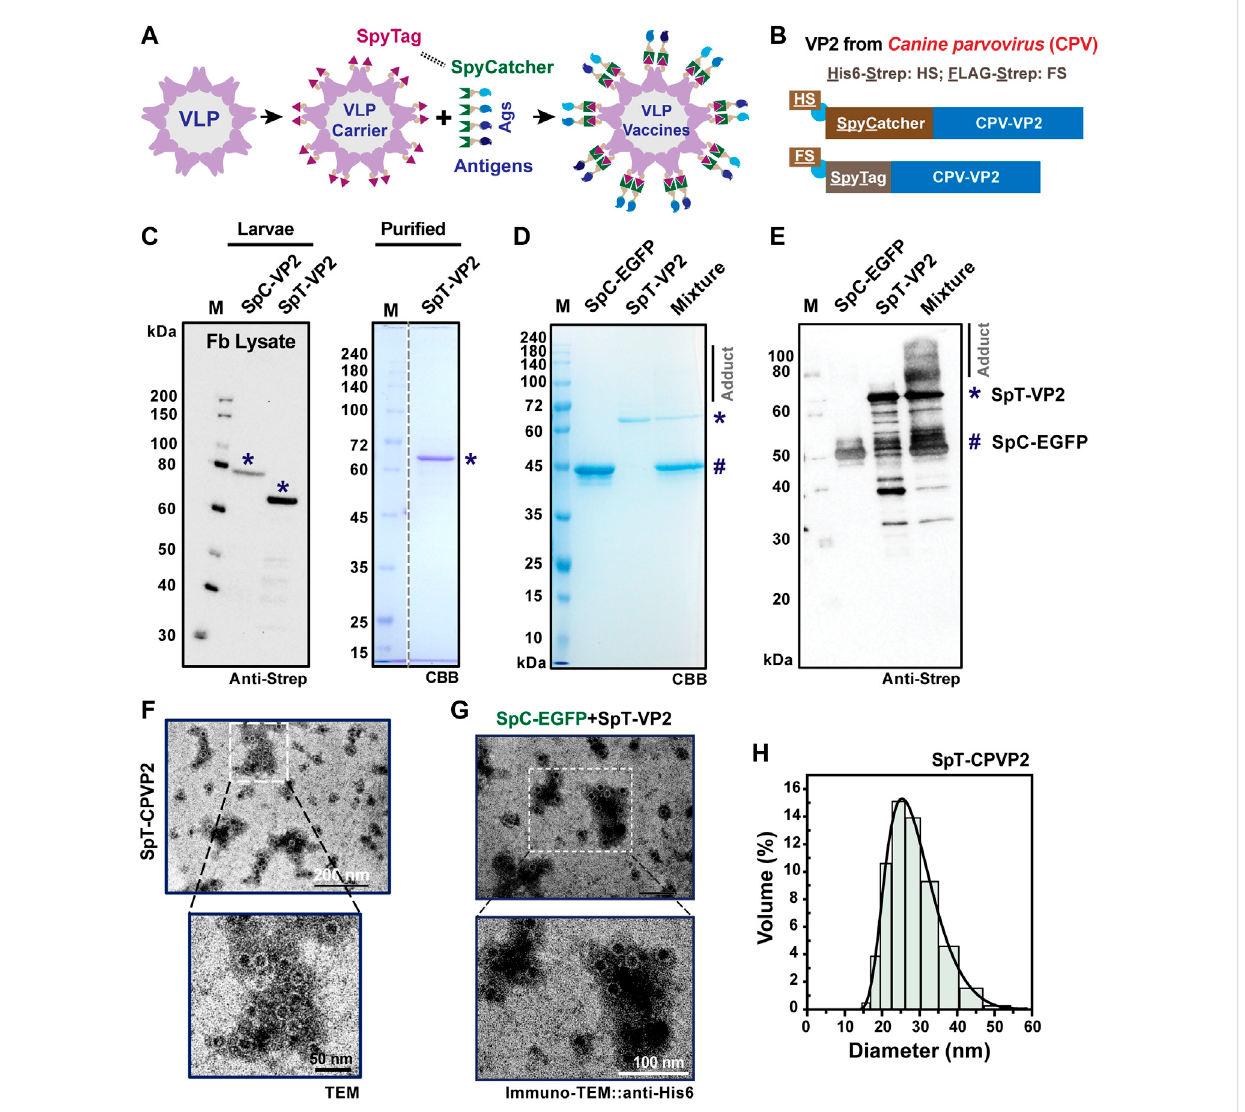
FIGURE 1 SpyCatcher-SpyTag-mediated protein-protein ligation in VP2-derived VLP platform. A schematic representation of protein or antigen (Ags) displayed on the VLP surface is shown in (A) . SpyCatcher (SpC, His6-StrepII (HS)-tagged) or SpyTag (SpT, FLAG-Strep II (FS)-tagged) was designed to attach at the N-terminus of CPV-VP2 for surface exposure, and the reaction between SpC and SpT (B) . The expressionof SpC- or SpT-fused VP2 protein was veri fi ed in the cultured Bm5 cells (C) , indicated by *) by western blot using Strep-tag II antibody. The SpT-VP2 protein was further puri fi ed from the fat body of virus-infected silkworm larvae (*). The in vitro covalent binding ef fi ciency was performed between puri fi ed SpT-VP2 (*) and SpC-EGFP (#) proteins in both CBB (D) or western blot (E) , anti-Strep). The adduct can be seen clearly in the western blot, although only smear bands were detected in CBB gels. SpT-VP2 can structurally form VLPs with a typical diameter of 20 – 25 nm as assayed in transmission electron microscopy (TEM) and